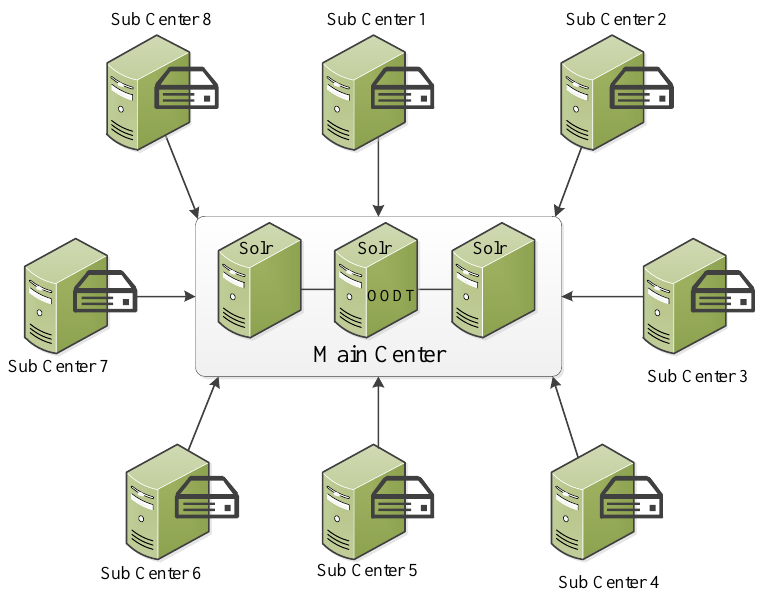
Figure 8. The framework of the virtual multi-center data